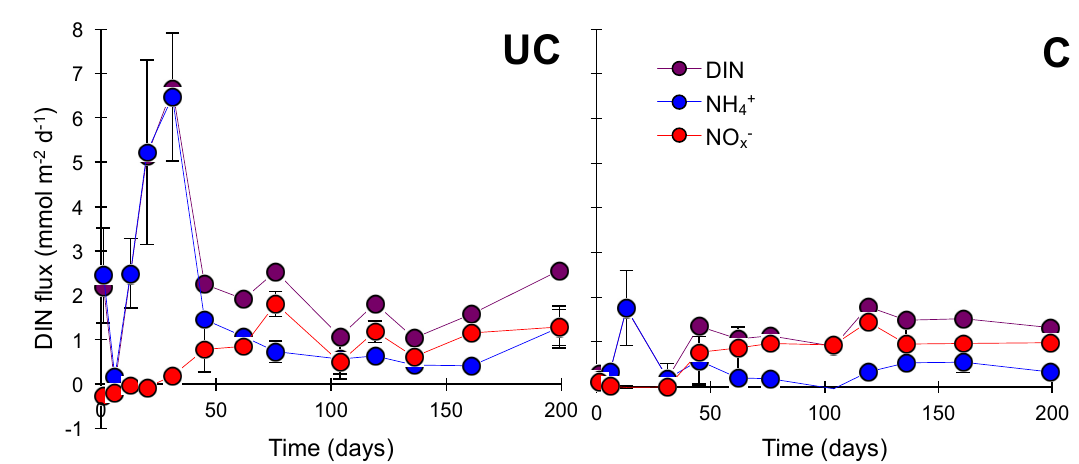
Figure 3. DIN effluxes (NH 4+ efflux + NO x − efflux) measured over 199 days on flooded cores from the uncultivated (UC) and cultivated (C) stations. Error bars indicate SEM ( n = 3). Porewater concentrations of NH 4+ (Figure 1b) showed similar time trends in both soils. NH 4+ accumulated gradually from almost 0 mM at Week 1 to ~0.5 and ~1.6 mM at stations UC and C, respectively, with the highest concentrations being detected in the 5–15 cm depth horizon. NO x −